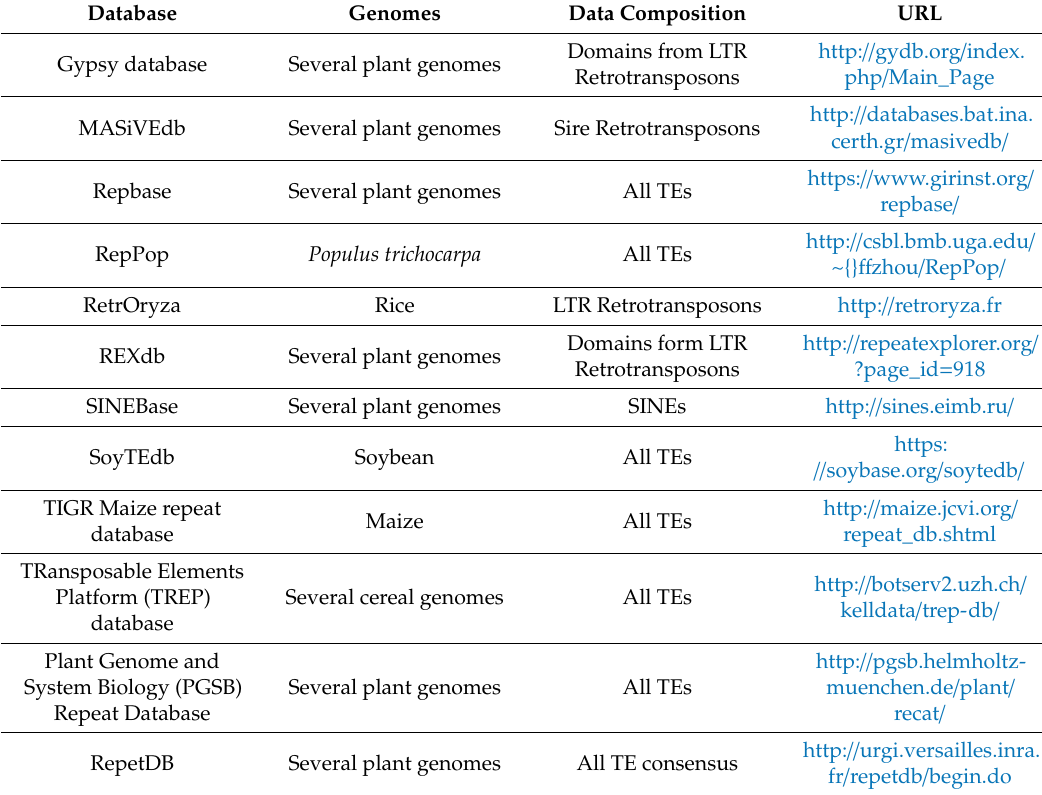
Table 5. TE databases